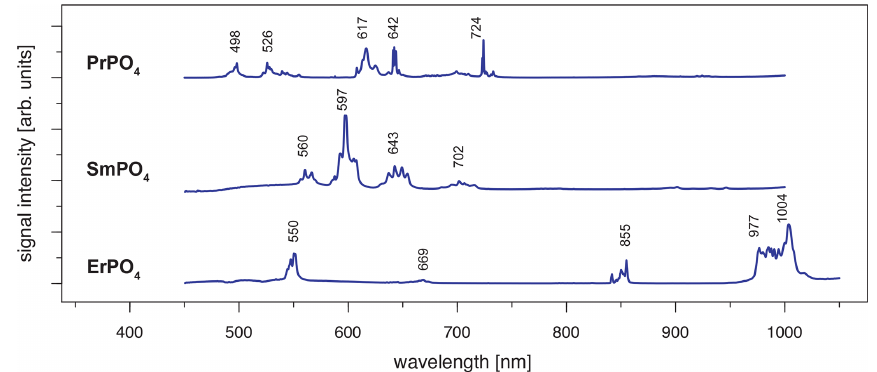
Figure 6. LiF reference spectra obtained with 442nm laser excitation depict the diagnostic emission lines for the REE phosphates PrPO 4 , SmPO 4 and ErPO 4 (given values represent wavelength of most intense emission in nanometres for each transition; cf. Table 3).